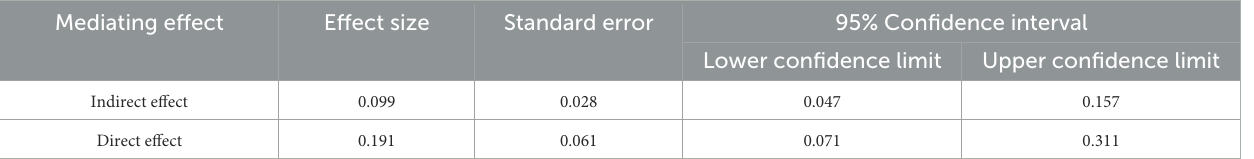
TABLE 5 Bootstrap test for mediating effect